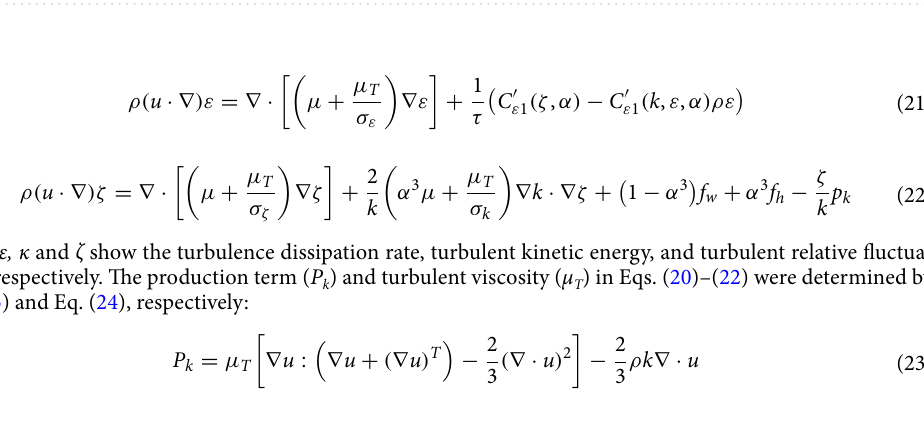
Figure 3. Considered line-type for the convergent section of the Laval nozzle (left) and diffuser